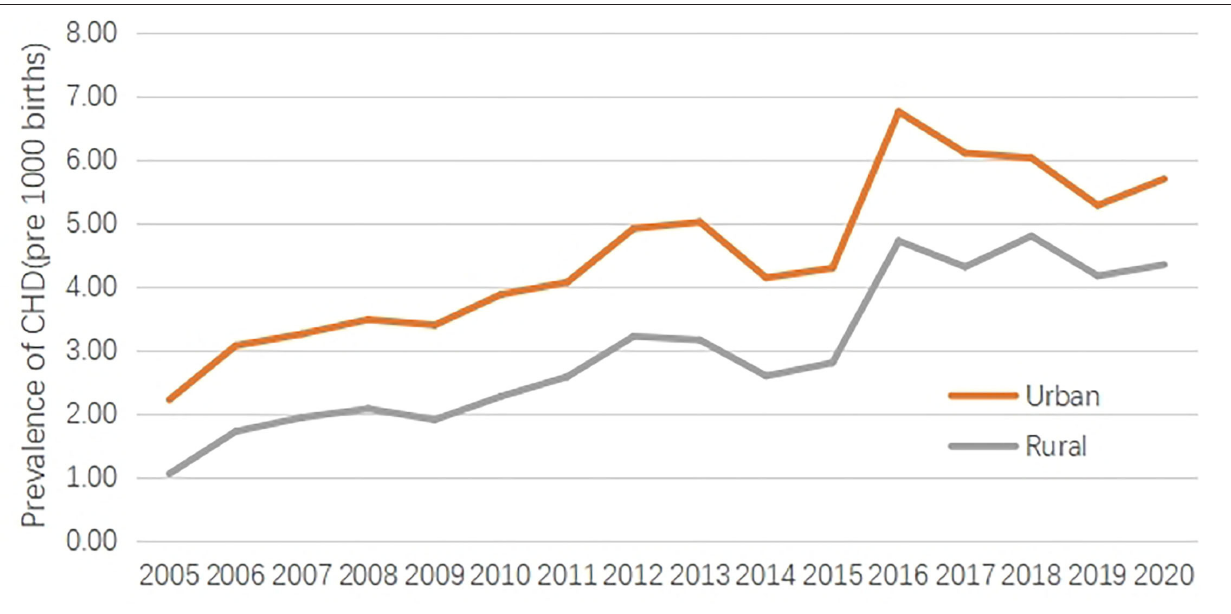
FIGURE 1 | The prevalence of CHD between urban areas and rural areas from 2005 to